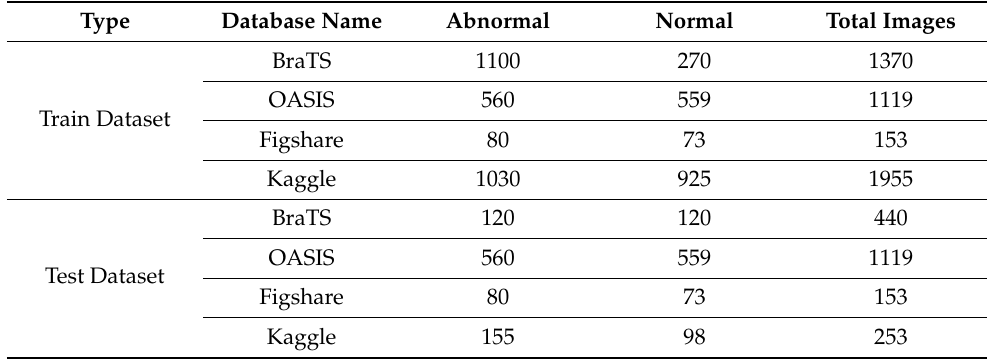
Table 1. Distribution of the set of images from each dataset for training and validation.